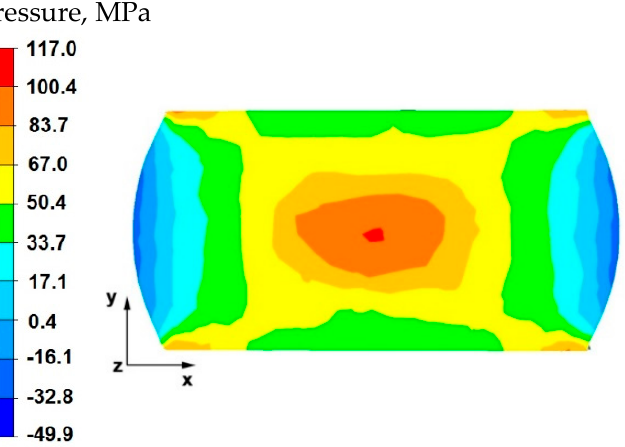
Figure 16. Distribution of hydrostatic pressure on the surface of the cross-section of the sample with modeled discontinuity after deformation with 35% reduction.